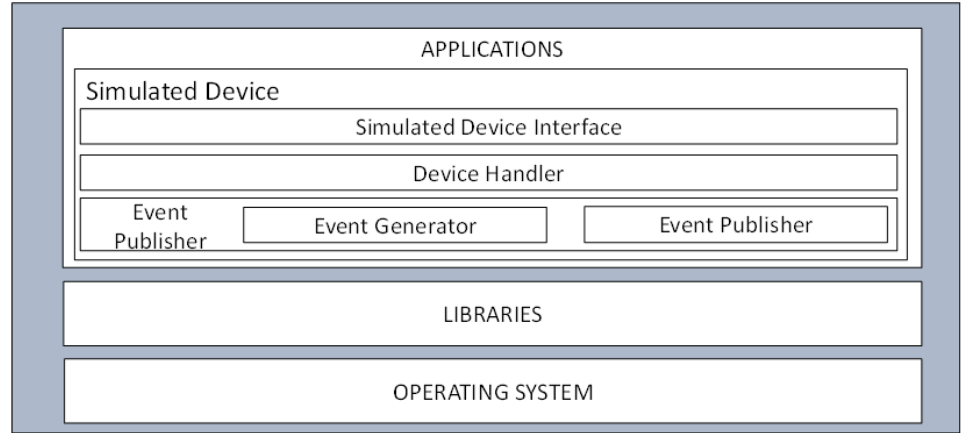
Figure 5. Development Model of the Simulated IoT